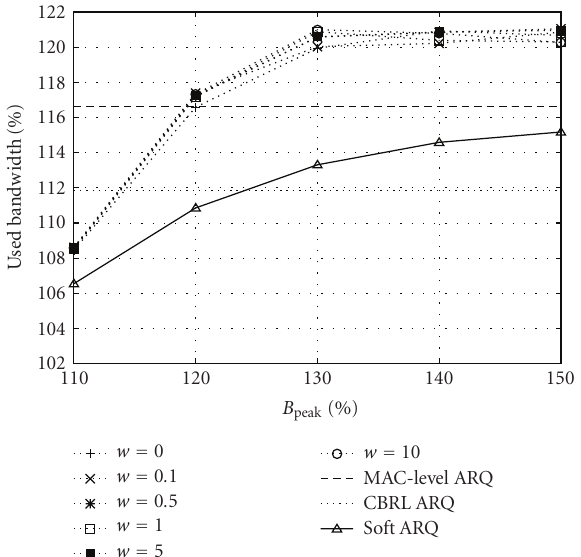
Figure 10: PSNR as a function of the peak bandwidth for the pro- posed ARQ scheme for di ff erent values of the w parameter, com- pared to the Soft ARQ technique and to the best performance of the MAC-level and CBRL ARQ schemes ( paris sequence.) Transmission through the relay node.